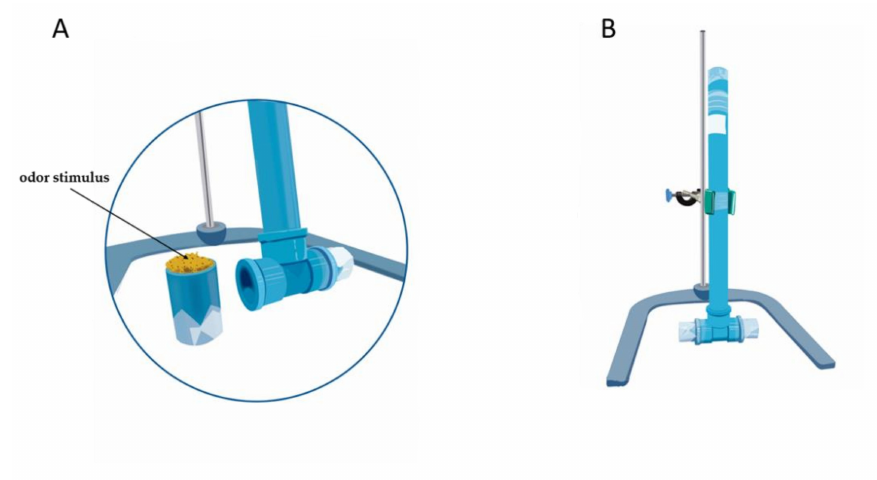
Figure 2. Modified T-shaped olfactometer. ( A ) Arm containing the odor stimulus and ( B ) universal support where the olfactometer was attached during the